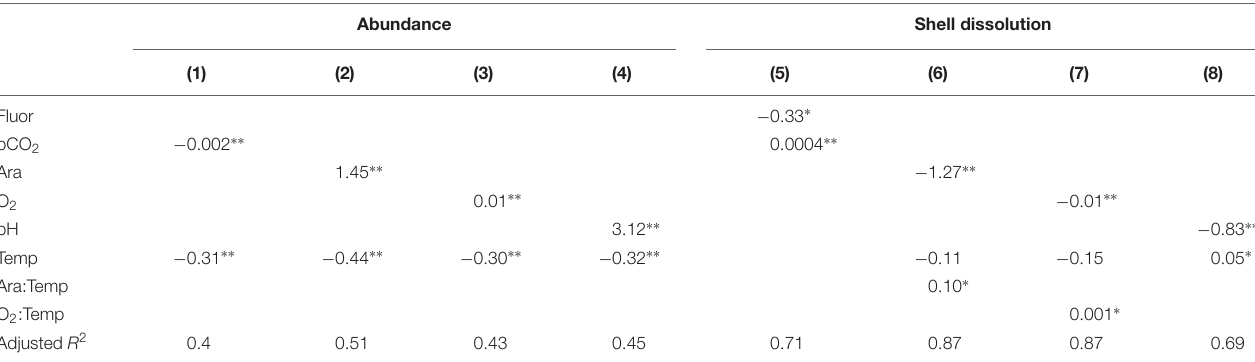
TABLE 3 | Model results for physiological and abundance responses to pairs of co-occurring environmental